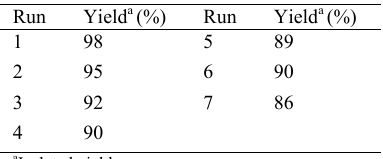
Table 4 . Reusability of the catalyst in the Suzuki reaction of 4-bromobenzen with phenylboronic acid